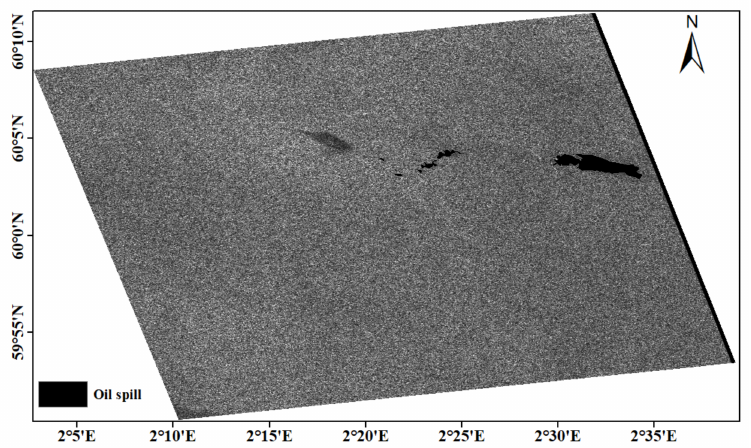
Figure 10. The oil spill image of RADARSAT-2 in the quad-polarization imaging mode used in this study. This image contains clear sea, oil emulsion, and crude